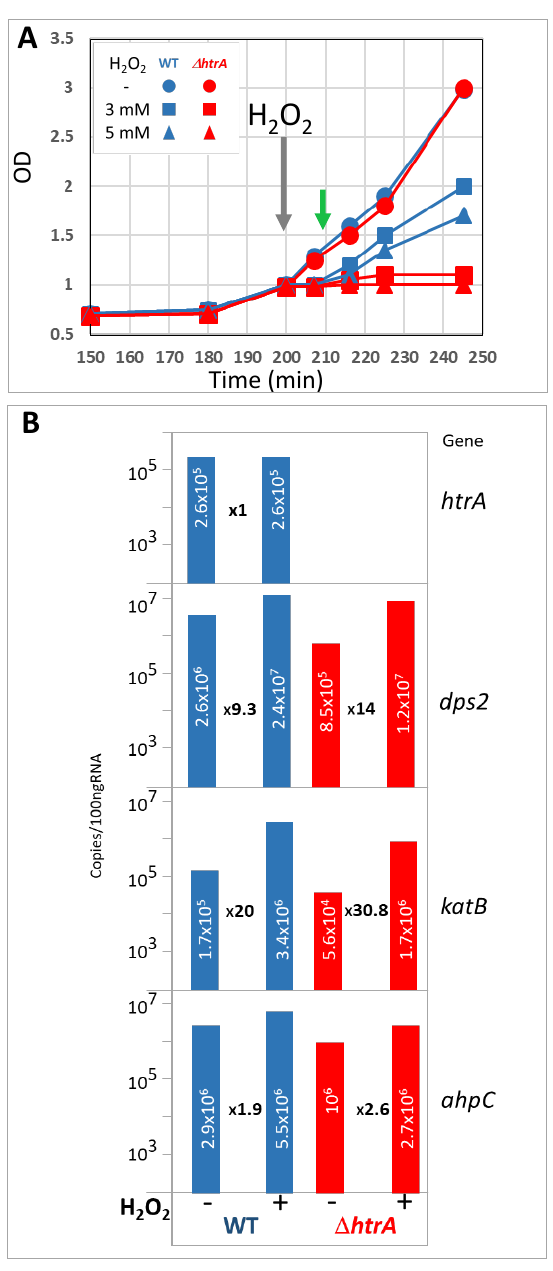
Figure 1. Hydrogen peroxide e ff ect on the growth profiles and expression of selected genes of B. anthracis WT and ∆ htrA strains. ( A ) Hydrogen peroxide e ff ect on the growth profiles of B. anthracis WT and ∆ htrA strains. The two strains were grown in BHI media for 3 h, then split into twin cultures and treated with 3 mM or 5 mM H 2 O 2 , as indicated (see inset legend). The gray arrow indicates the time point after addition of H 2 O 2 at cell densities of OD600 = 1. Full growth curves of various strains of B. anthracis were previously extensively documented [13,44,45,57]. ( B ) Hydrogen peroxide e ff ect on expression of selected genes belonging to the oxidative stress regulon. RNA was prepared from samples collected 10 min after onset of H 2 O 2 treatment (see green arrow in panel A). Transcription levels of the genes htrA (GBAA3660), dps2 (GBAA5290), katB (GBAA1159), and ahpC (GBAA0345) were determined by qRT-PCR. The measured values (expressed as copies / 100 ngRNA) are indicated within the histograms. The fold increase in the abundance of each transcript upon H 2 O 2 treatment is indicated between the histograms. The data depicted were obtained in one representative experiment, of three independent iterations, which yielded similar results ( < 10%